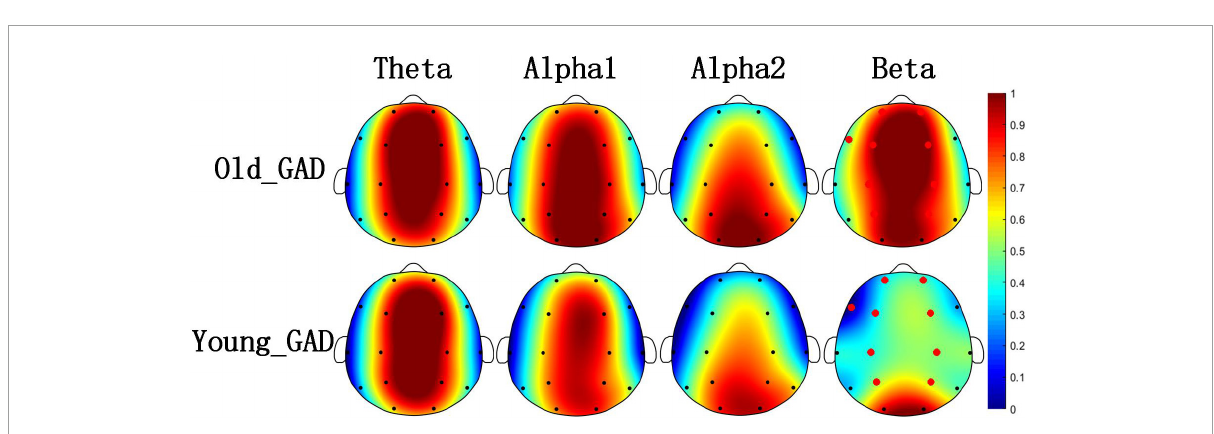
FIGURE2 Brain topography of average fuzzy entropy (FE) of four rhythms (theta, alpha1, alpha2, and beta). The average FE of Old_GAD and Young_GAD have been normalized between 0 and 1, so they shared the same color bar. The red dots indicated the significantly differential electroencephalogram (EEG) channels between the Old_GAD and Young_GAD ( p <